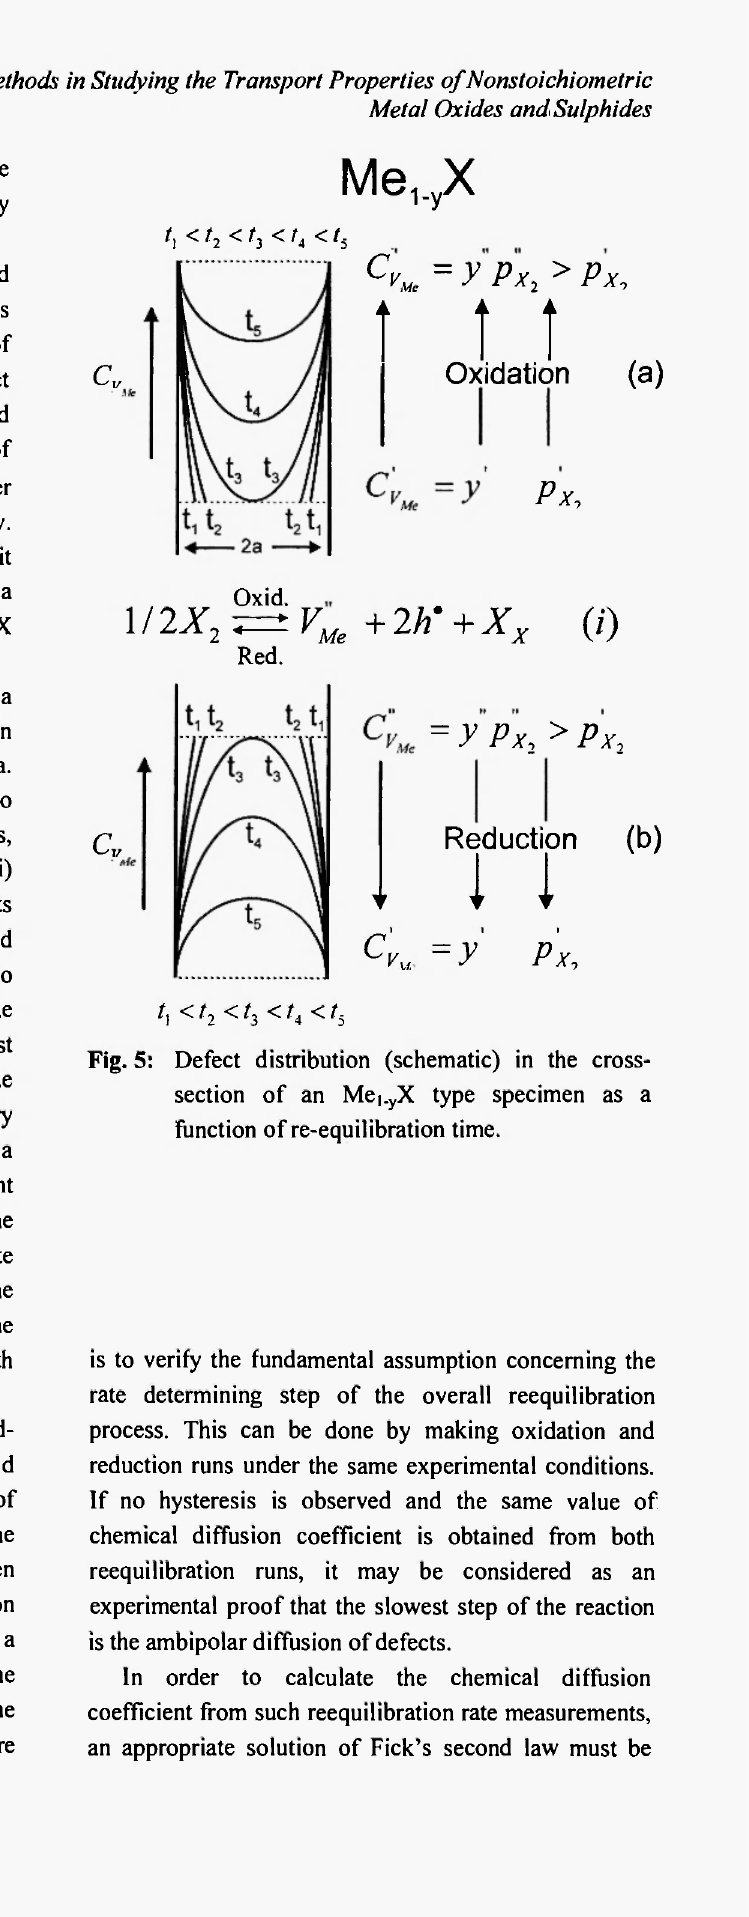
Fig. S: Defect distribution (schematic) in the cross- section of an Mei. y X type specimen as a function of re-equilibration